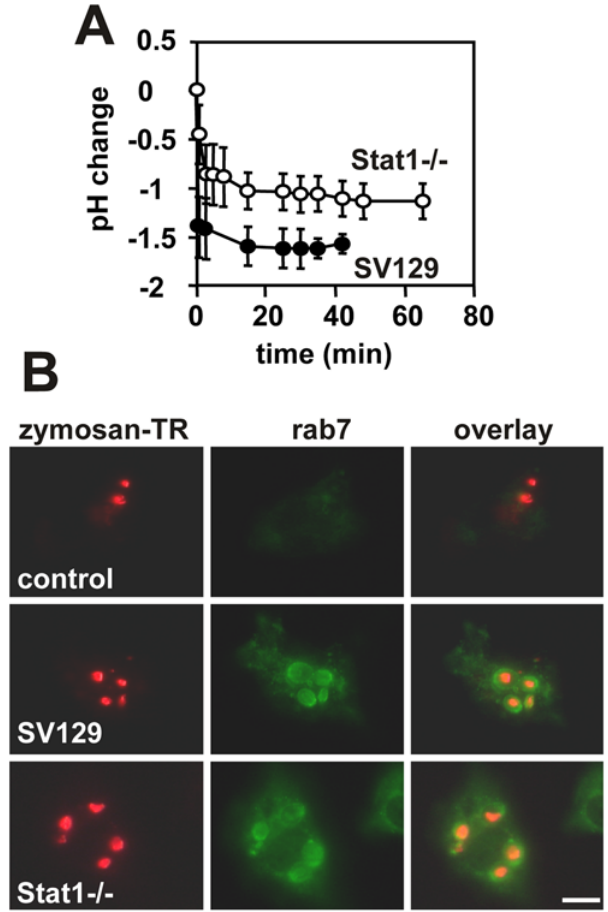
Figure 4. Stat1-deficient PEMs are normal in phagosome maturation. (A) Kinetics of phago-lysosomal fusion. Monolayers of SV129 control and Stat1 2 / 2 PEMs were incubated with FITC-labeled zymosan at 4 u C for 20 min. Phagosomal pH was monitored by ratio- fluorescence determination during synchronized phagosome formation and acidification at 37 u C. (B) Indirect immunofluorescence analysis. Control and Stat1 2 / 2 PEMs were incubated on ice with TexasRed- labeled zymosan for 20 min and synchronous uptake was established by temperature shift to 37 u C. Cells were fixed at time points 0, 30 (shown here), 60 and 90 min after uptake, and subcellular localization of the lysosomal marker rab7 was assessed by indirect immunofluores- cence. Control cells were stained with the FITC-conjugated secondary antibody alone. The bar corresponds to 10 m m.